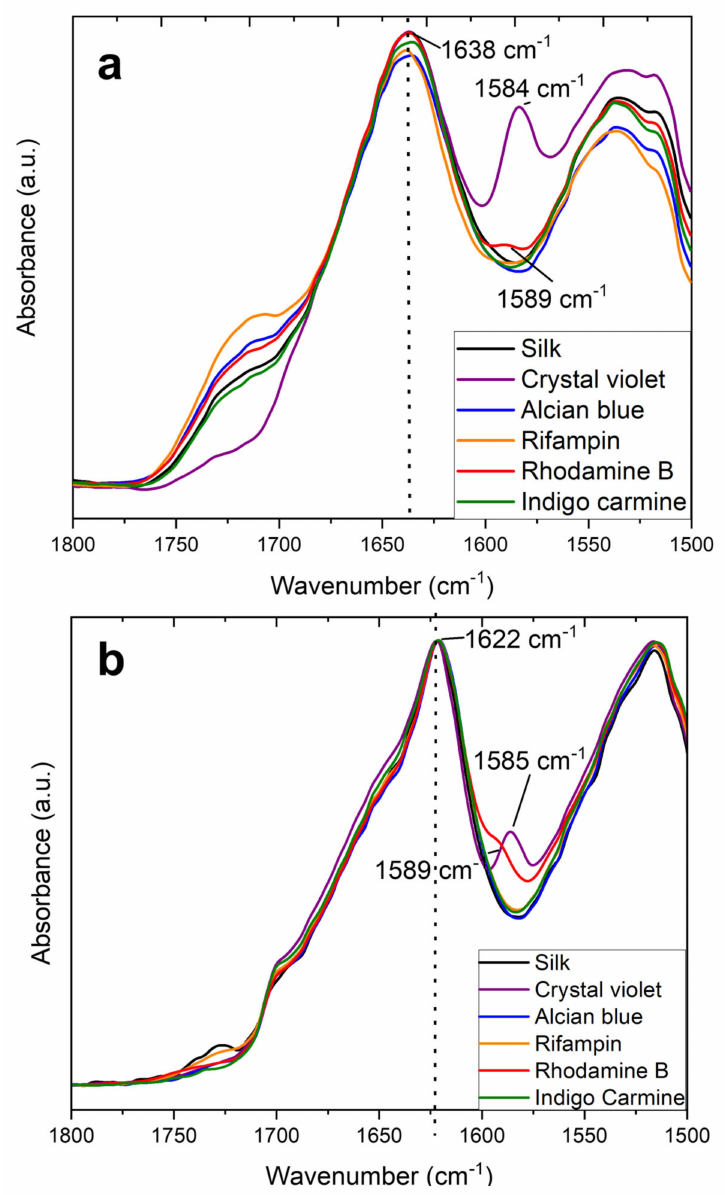
Figure 2. FTIR spectra of the Amide I and II regions of silk thin films ( a ) before and ( b ) after release of model